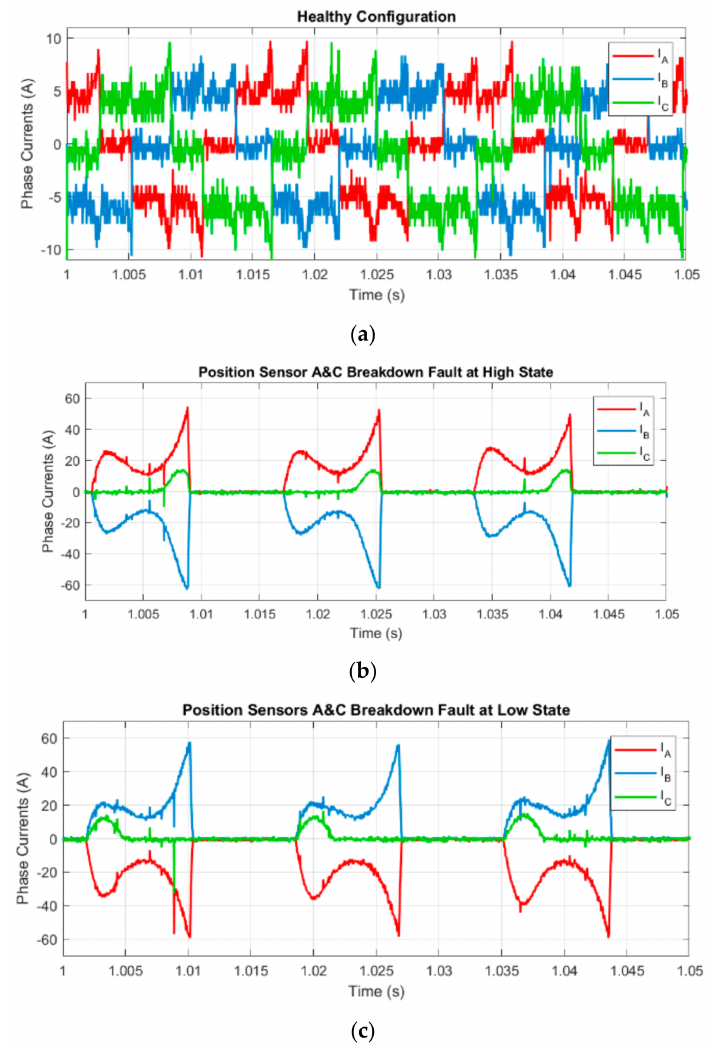
Figure 22. Experimental investigation of motor phase currents under double position sensor break- down fault. System operation at 900 rpm and no load in case of healthy and defective configurations. ( a ) Waveform of phase currents at healthy configuration; ( b ) Waveform of phase currents at defec- tive configuration of position sensor A at high state; ( c ) Waveform of phase currents at defective configuration of position sensor A at low